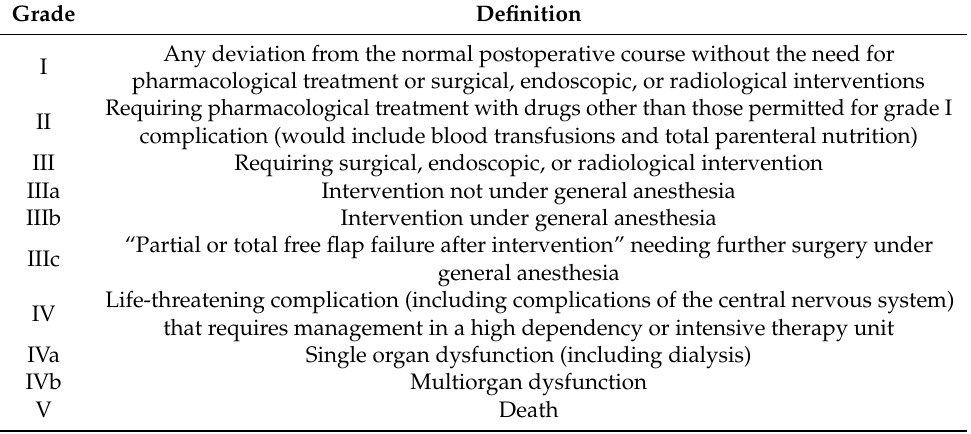
Table 4. Modified Clavien–Dindo classification for free flap reconstruction in patients with head and neck